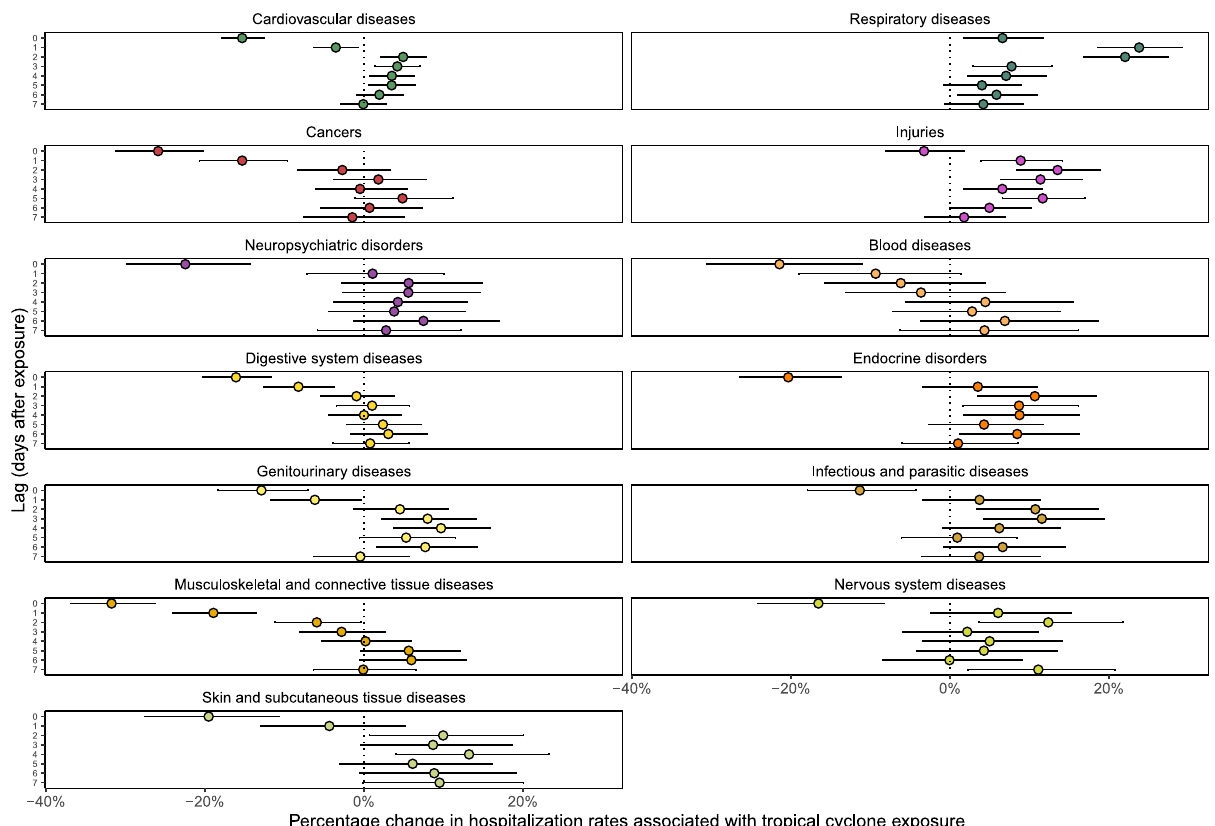
Fig. 3 Percentage change in hospitalization rates with tropical cyclone exposure by cause of hospitalization and lag time. Lag time is measured in days after tropical cyclone exposure. Dots show the point estimates and error bars represent Bonferroni-corrected 95% con fi dence